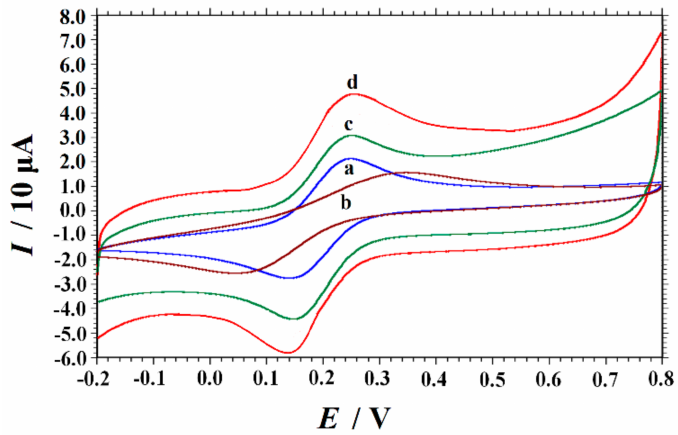
Figure 2. Cyclic voltammograms (CVs) of 1.0 mM potassium ferricyanide containing 1.0 M KCl solution plotted at di ff erent electrodes: ( a ) GCE, ( b ) PVP / GCE, ( c ) GR / GCE and ( d ) PVP-GR / GCE. Scan rate: 0.1 V s − 1